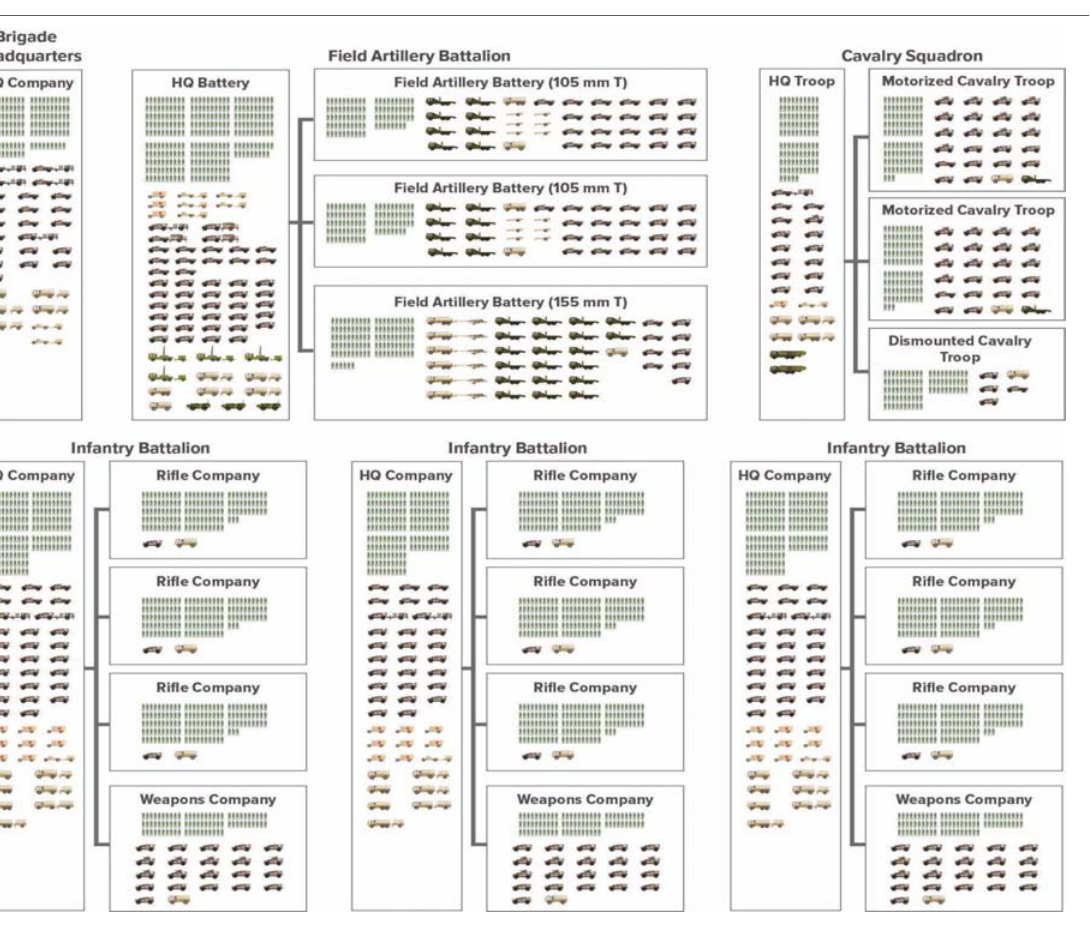
Figure 1. Units, equipment, and personnel in an Army Infantry Brigade Combat Team, excluding support battalion